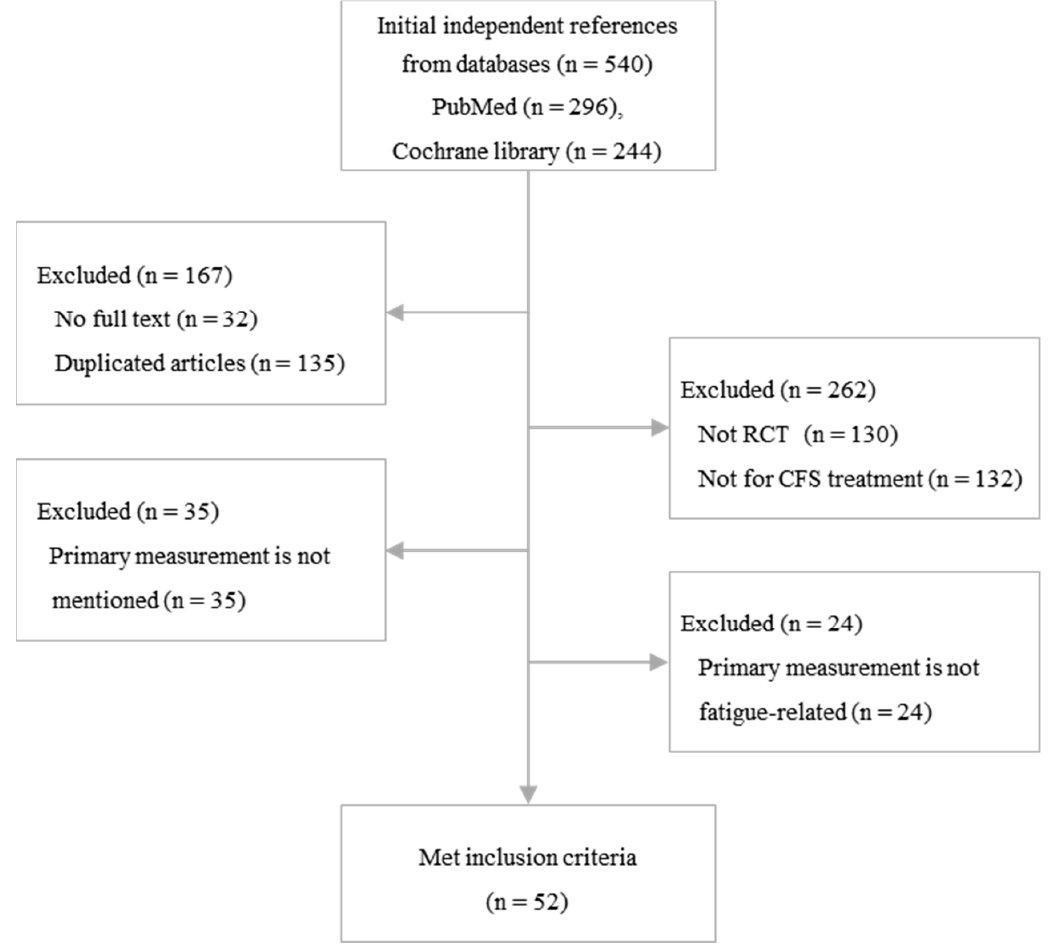
Figure 1. Flow chart of the study.